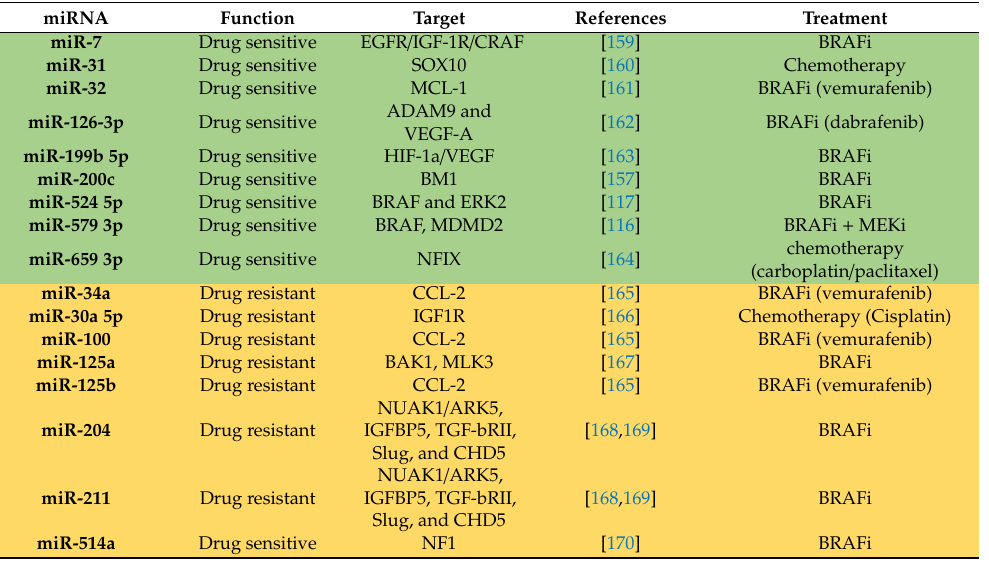
Table 2. The most representative miRNAs that are drug sensitive (green) and drug resistant (orange) to target-based therapy and chemotherapy in melanoma